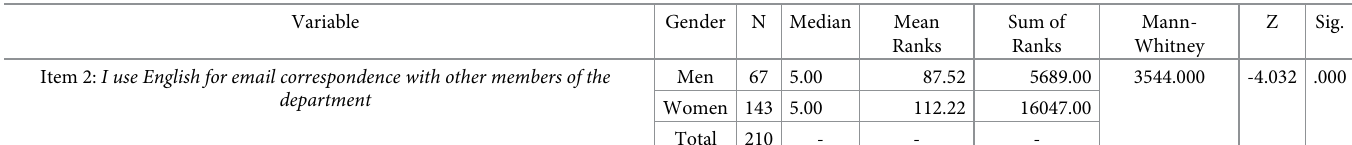
Table 4. Mann-Whitney test.